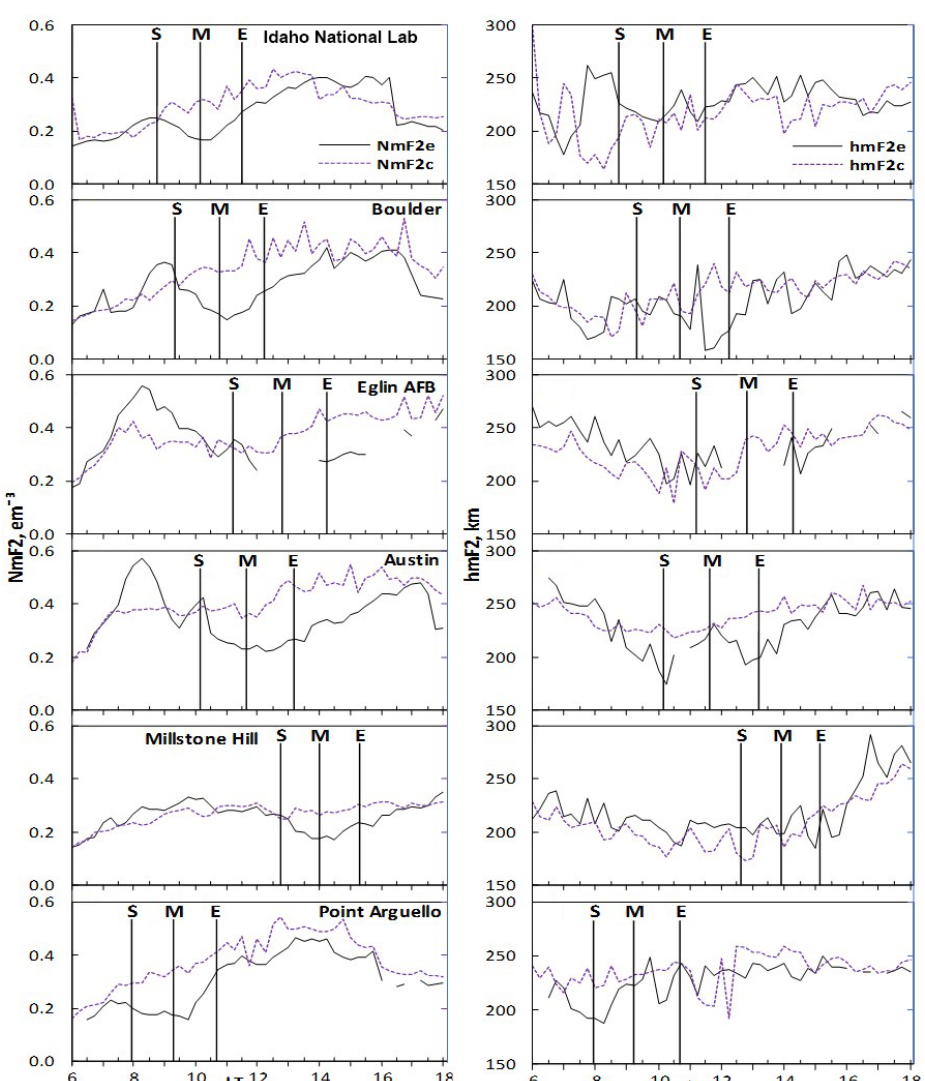
Figure 2. Ionospheric NmF2 and hmF2 variations during the eclipse day (black continuous line) and the control day (dash blue line) were presented to delineate the effect of the solar eclipse of 21 August 2017 on the ionosphere. The three vertical lines represents the different phases of the eclipse (S – start time of the initial phase, M – the period of the maximum magnitude of the eclipse, and E – the end time of the recovery phase or the last contact of the eclipse progression). The local time of the respective eclipse contact points for each station are given in Table